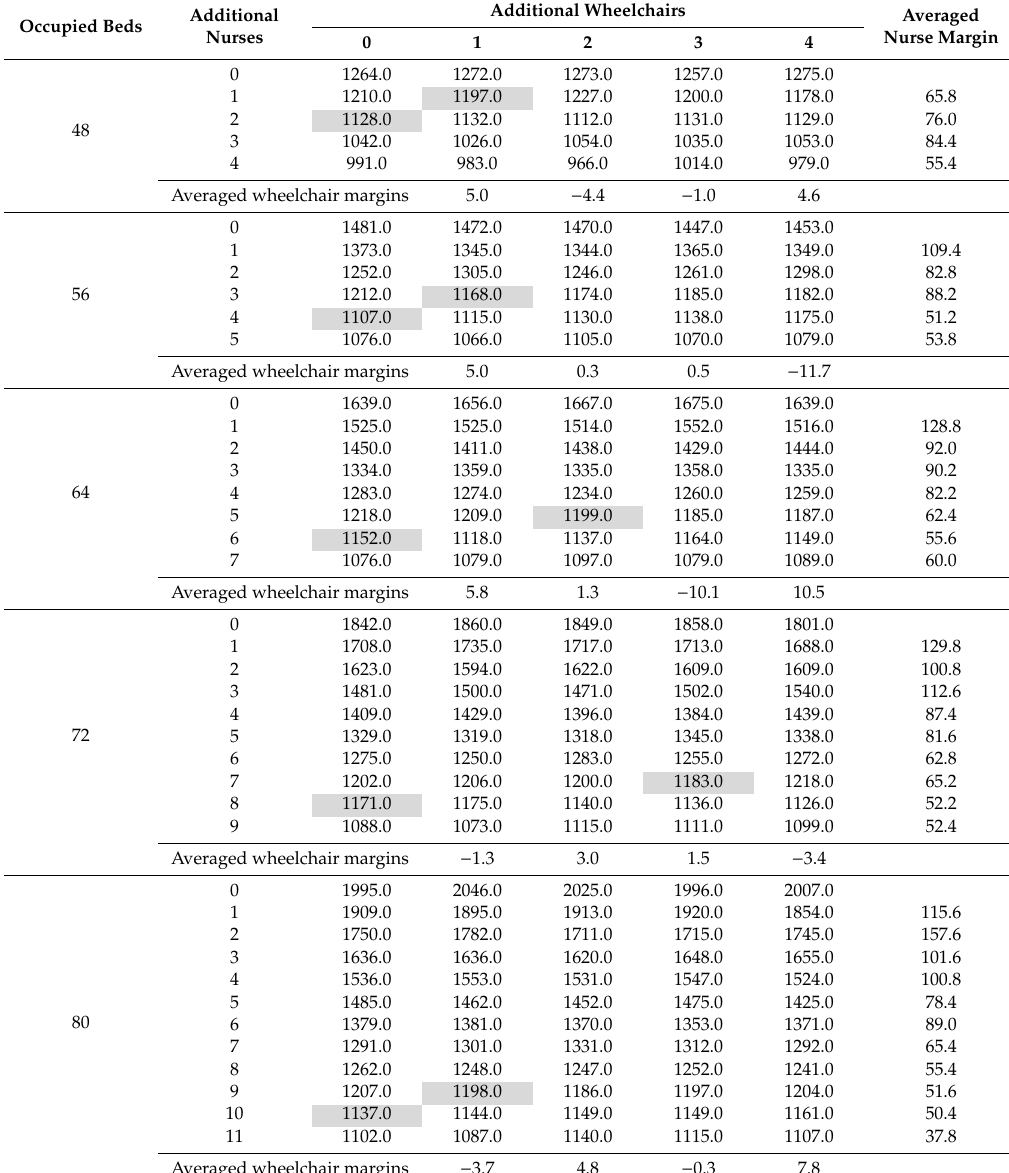
Table 5. The maximum evacuation times for the thirty simulation